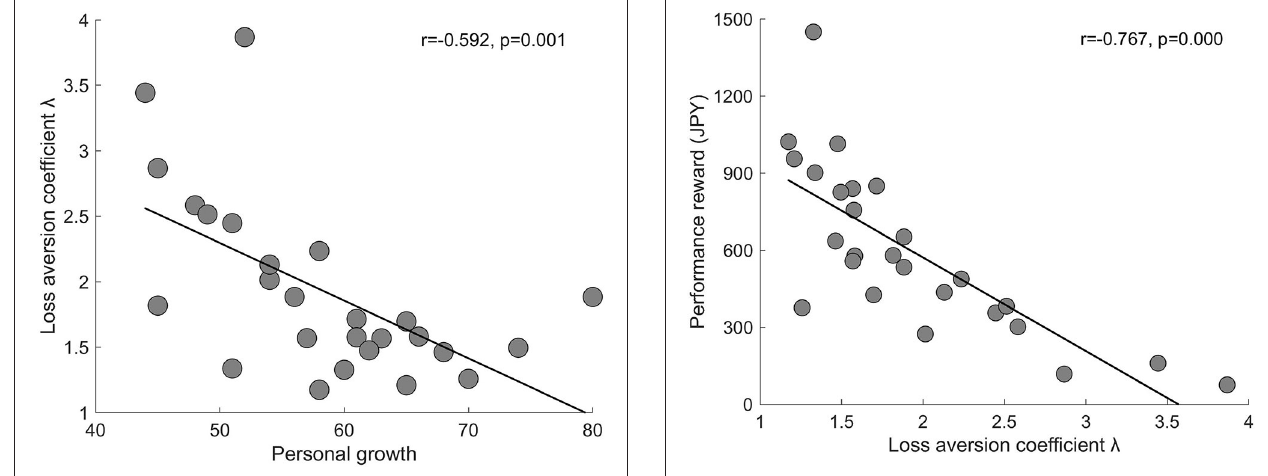
FIGURE 3 | Scatter plot (with a regression line) of the association between personal growth and LA coefficient λ . Each circle represents a subject. n = 26.